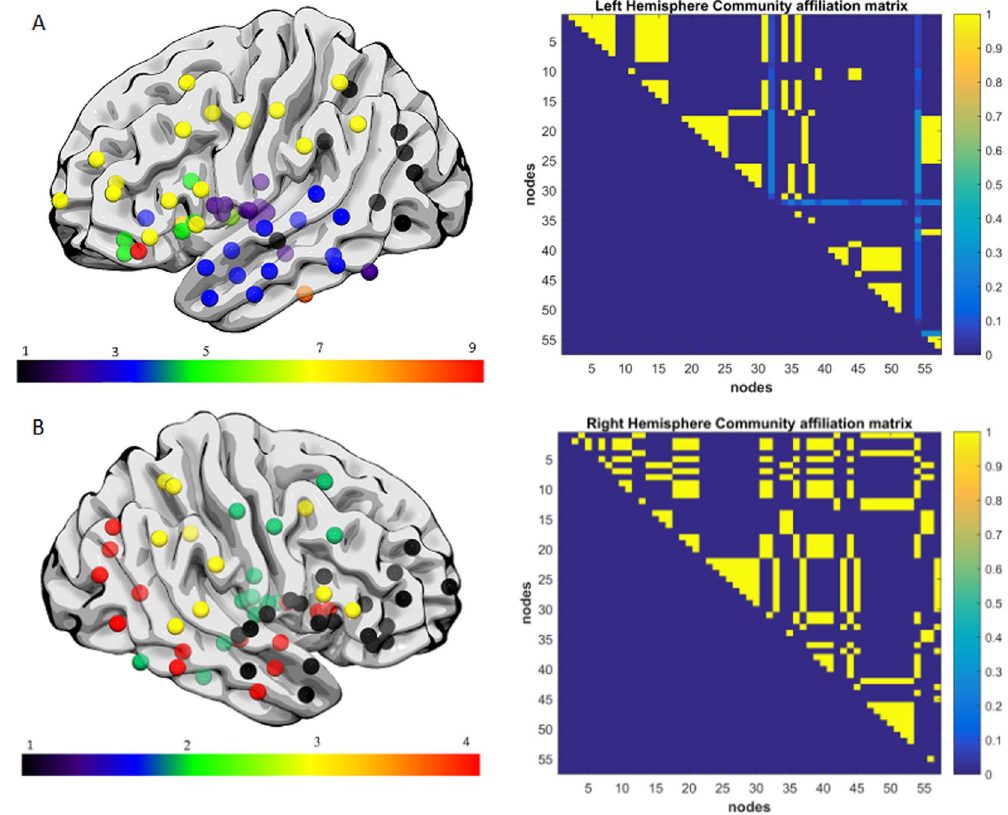
Figure 7. ( A ) Exemplar data Subject 3, each color represents a single community left hemisphere lateral view. There was marked fragmentation of the inferior frontal and middle-temporal networks with relative disconnection between the frontal and subcortical regions, with the left hemisphere grouping into 9 modules. Subject 3 had a lesion volume of 99.24 cm 3 , percent white matter damage of 0.096, and a WAB-AQ score of 58.2. There was unstable clustering and missing nodes in the community affiliation matrix compared to the right hemisphere matrix. ( B ) Exemplar data Subject 3, right hemisphere lateral view, each color represents a single community. There was no apparent fragmentation, and the network was divided into 4 communities. The community affiliation matrix showed relatively stable clustering over 100